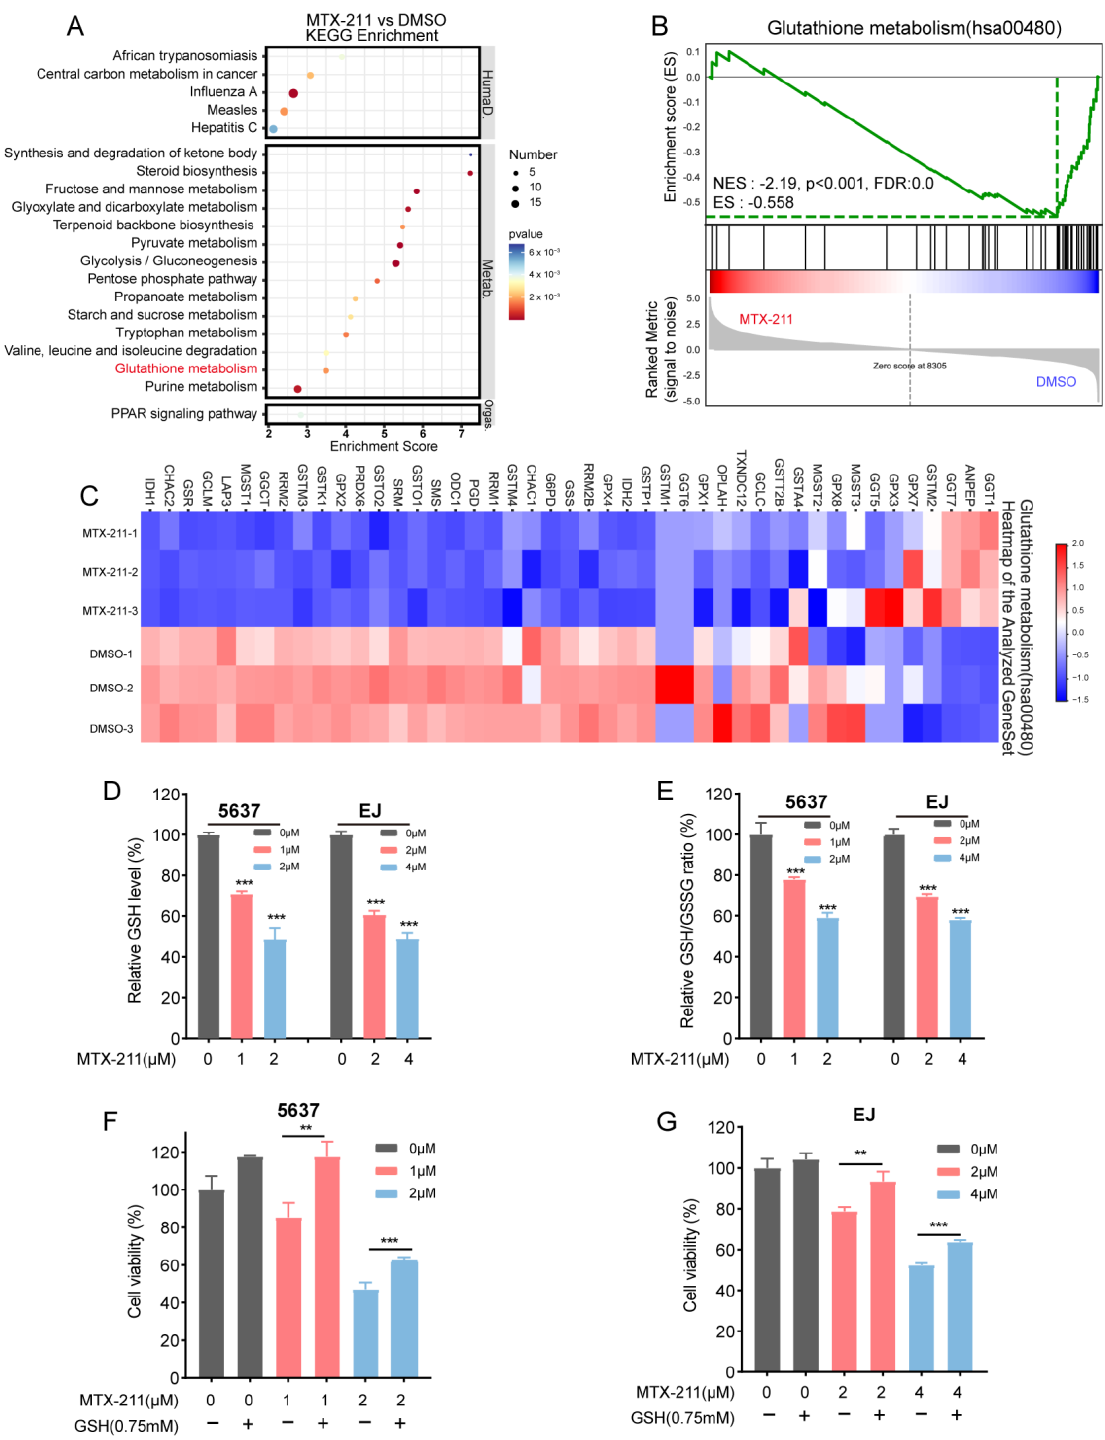
Figure 3. MTX-211 exerts antitumor effects by modulating glutathione (GSH) metabolism. ( A , B ) Kyoto Encyclopedia of Genes and Genomes (KEGG) pathway enrichment and Gene Set Enrichment Analysis (GSEA) between MTX-211- and DMSO-treated 5637 cells. ( C ) The heatmap of GSH metabolism gene set in MTX-211- and DMSO-treated groups. ( D , E ) The effect of treatment with different concentrations of MTX-211 for 48 h on the relative level of GSH and the relative ratio of GSH/GSH disulfide (GSSG) in 5637 and EJ cells. ( F , G ) The supplementation of GSH partially blocked the inhibitory effect of MTX-211 in 5637 and EJ cells. ** p < 0.01, *** p < 0.001.